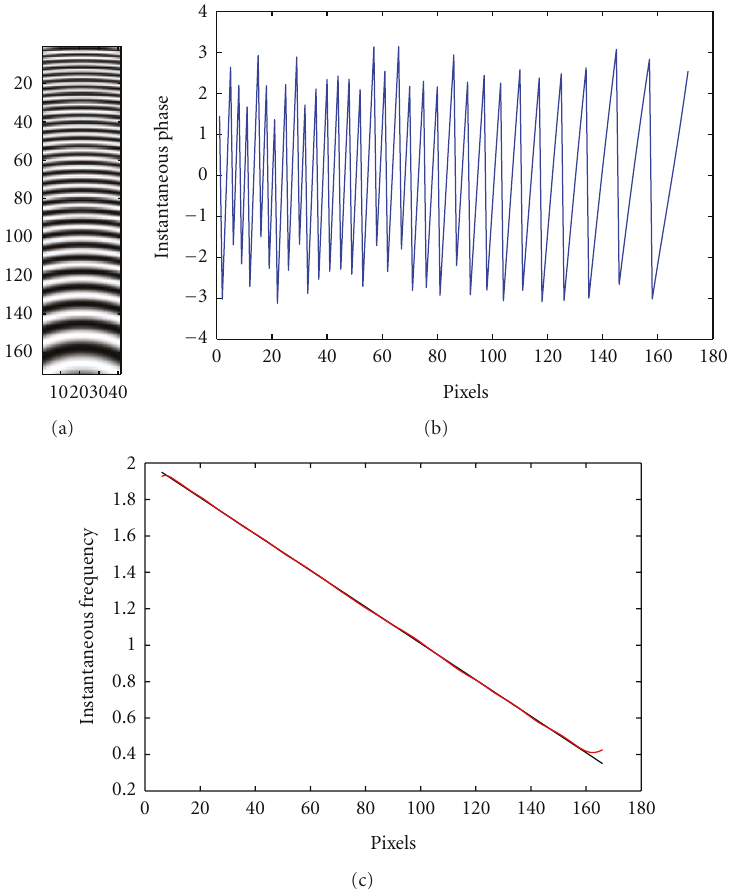
Figure 13: Radial instantaneous frequency magnitude estimation example (vertical) on noise-free chirp image: (a)–(c). Instantaneous frequency estimation based on S-G filter derivative method: (a) chirp image, (b) instantaneous phase calculated after application of uniform wavelength spacing-based uniform spacing filterbanks. (c) Comparison of estimated radial (vertical) IF magnitude (red) versus ground truth IF (black) for the chirp image. The discrete radial frequency magnitude is expressed in radians.